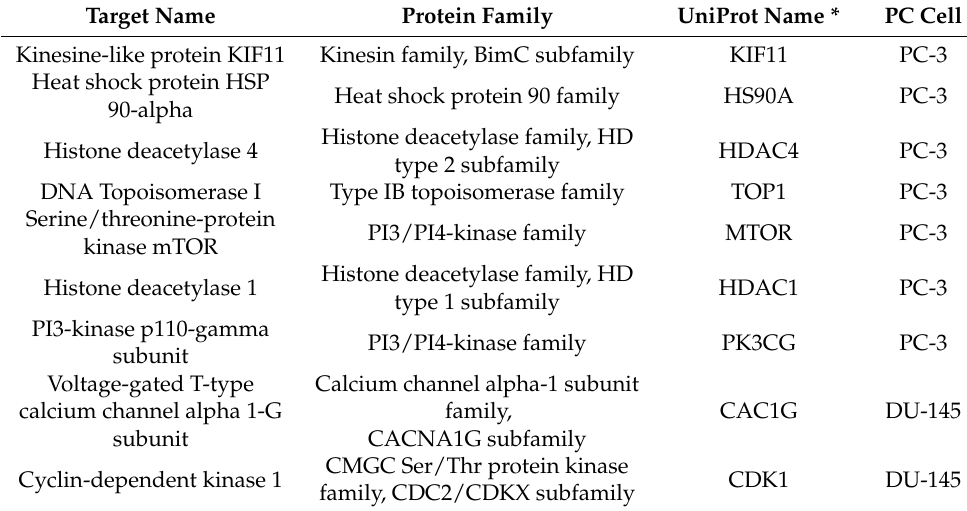
Table 1. Targets identified from the analyses performed in the CHEMBL dataset, whose inhibitory activity data correlate with the activity on PC cells. The table reports only targets whose lower confi- dence interval of Spearman’s Rho ( ρ s ) resulted as equal or higher than 0.4 ( ρ s ≥ 0.4, p -value < 0.001). Target Name Protein Family UniProt Name * PC Cell Kinesine-like protein KIF11 Kinesin family, BimC subfamily KIF11 PC-3 Heat shock protein HSP Heat shock protein 90 family HS90A PC-3 90-alpha Histone deacetylase family, HD Histone deacetylase 4 HDAC4 PC-3 type 2 subfamily DNA Topoisomerase I Type IB topoisomerase family TOP1 PC-3 Serine/threonine-protein PI3/PI4-kinase family MTOR PC-3 kinase mTOR